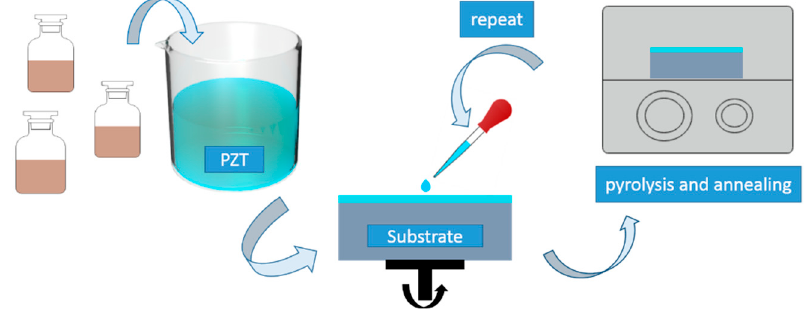
Figure 1. The schematic diagram of sol-gel process of Pb(Zr 0.53 Ti 0.47 )O 3 film.